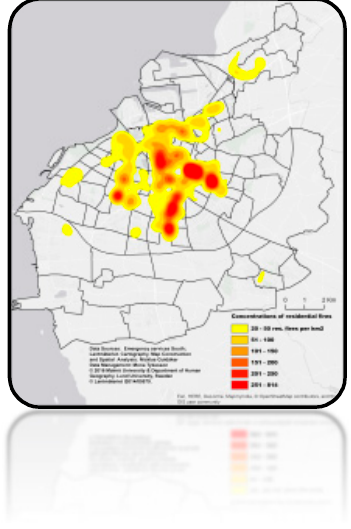
Figure 8. Heat Figure 8. Heat map.